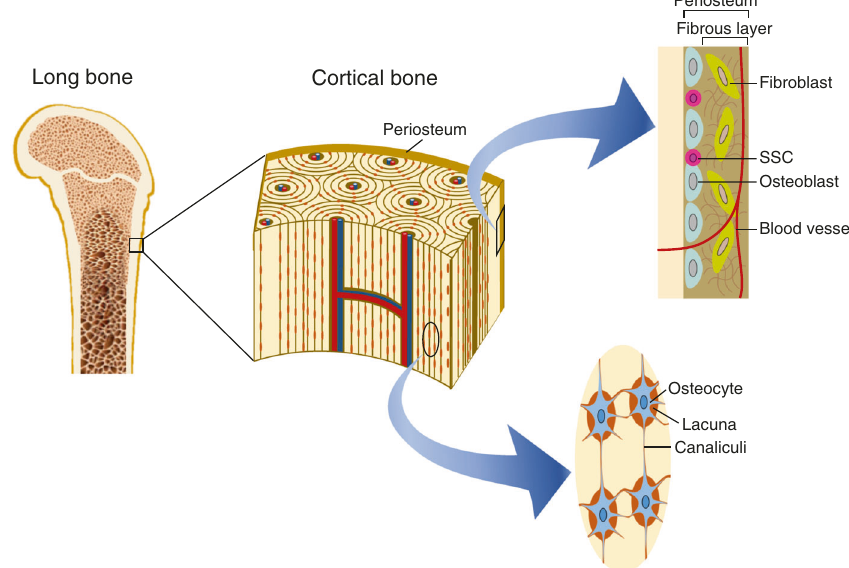
Fig. 3 The structure of the long bone, cortical bone, and periosteum. Osteocytes are embedded in the lacuna of the bone matrix and are connected with each other through dendrites surrounded by canaliculi. At the periphery of the bone, SSCs, and fi broblasts form the periosteum together with osteoblasts. Osteocytes and the periosteum are mechanical sensors in the bone